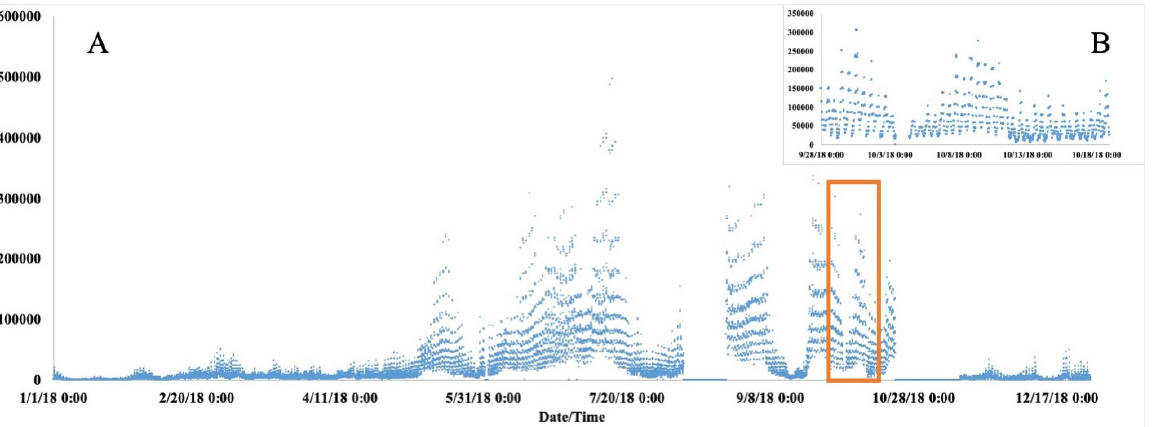
Figure A1. Calculated Vibrio spp. concentrations for site 021720709 CFUs/100 mL for 2018 including Hurricane Florence (top right corner inset, ( B )). ( A ) Calculated Vibrio spp. concentrations (in CFUs) for site 021720709 for all of 2018. Each point represents a 15-min detection window. ( B ) Calculated Vibrio spp. concentrations (in CFUs) for site 021720709 for the period during and after Hurricane Florence. The time window for ( B ) is indicated in ( A ) by the red box.